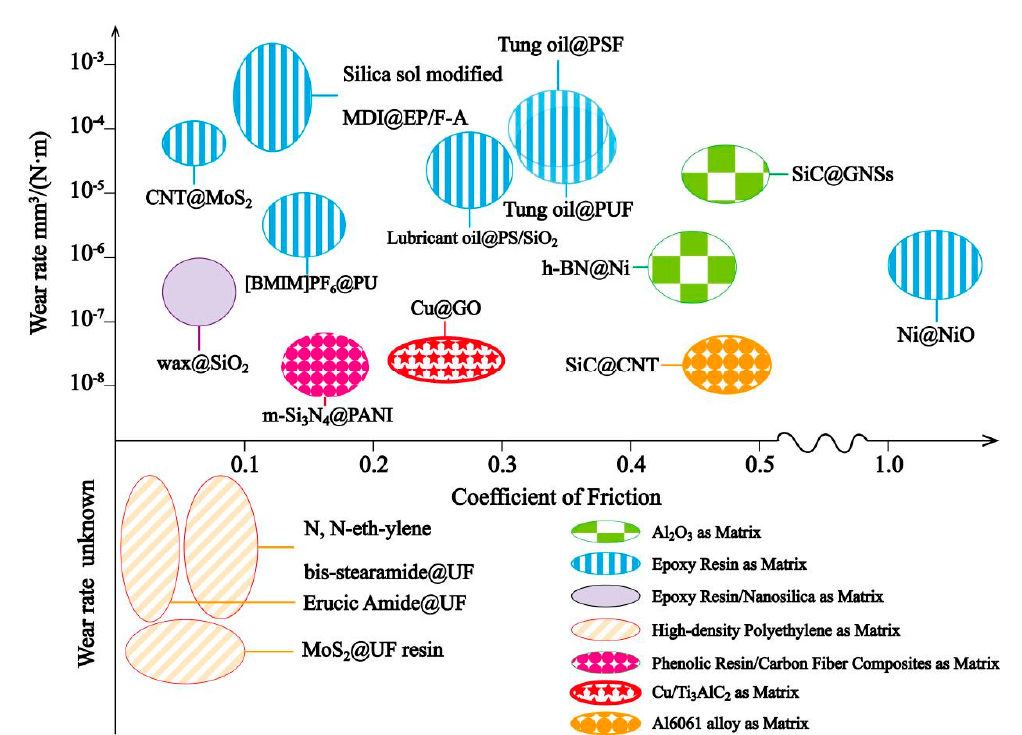
Figure 8. Tribological properties of different matrixes enhanced by core–shell particles.